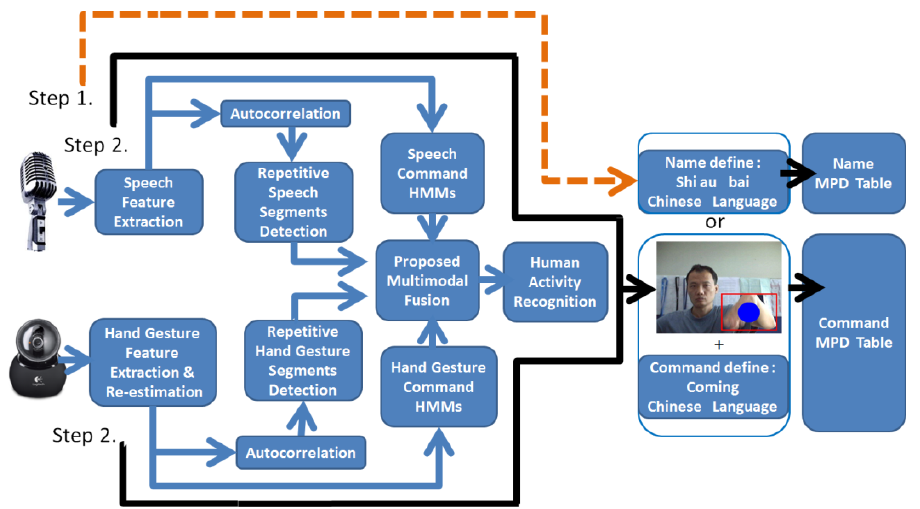
Figure 21. Human behavior recognition flow